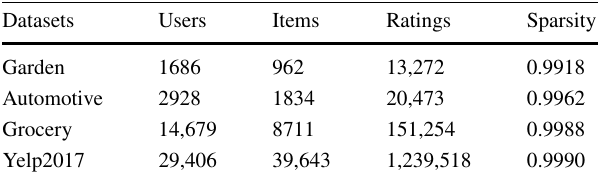
Table 2 Statistics of the datasets